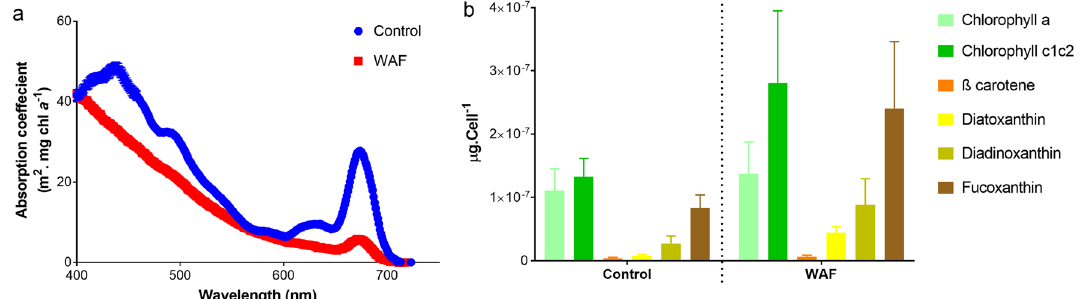
Figure 5. Light harvesting components of T. pseudonana . ( a ) average absorption coefficient, ( b ) average pigment composition of T. pseudonana (± standard deviation) after 48 h of incubation under Control and WAF treatments (n =